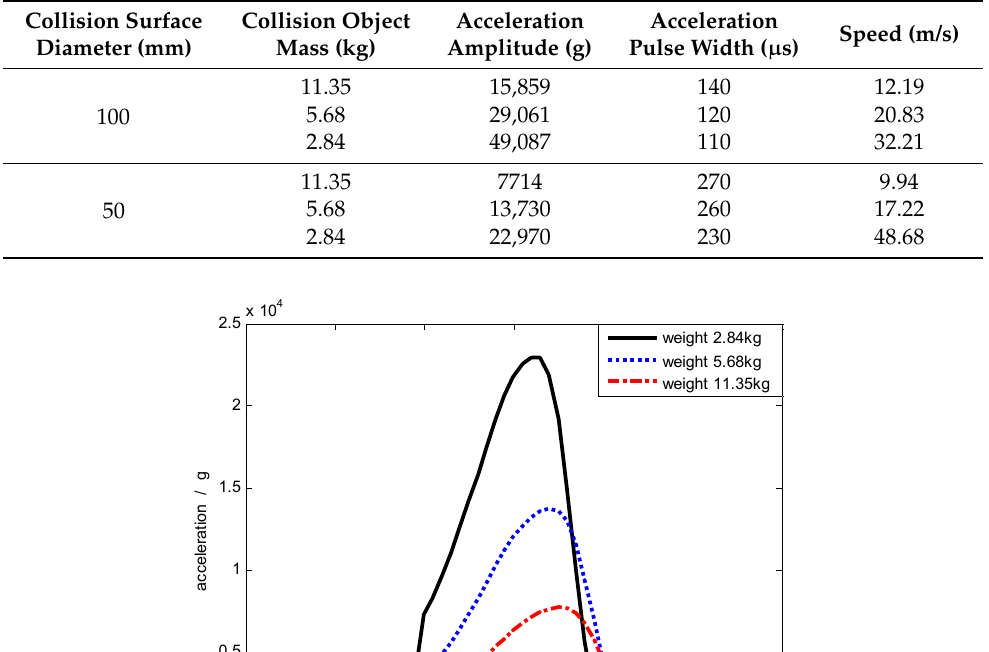
Figure 7. Finite element model of the collision process.